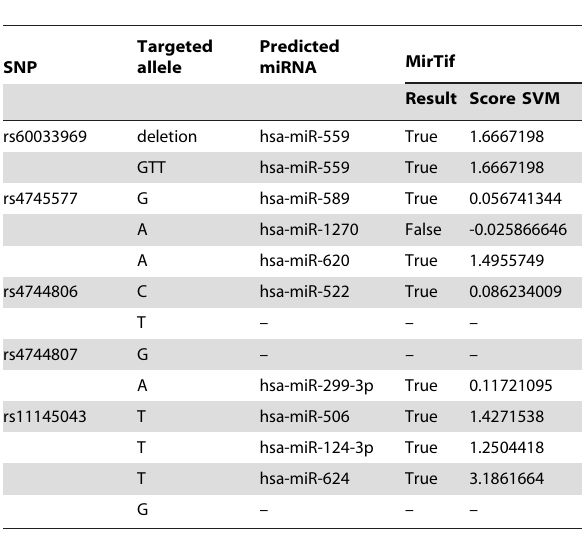
Table 4. Computational analysis of miRNA targeting on FXN 3 9